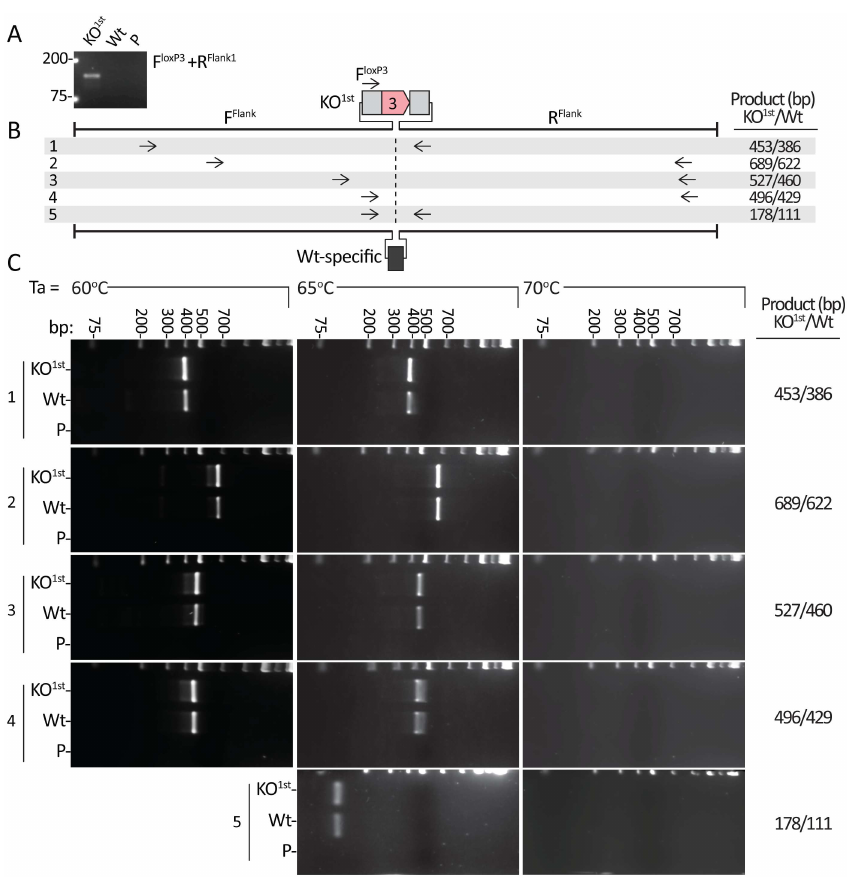
Fig 3. Targeting alternative flank positions or altering the PCR annealing temperature does not render templates containing the synthetic loxP3 region susceptible to amplification. A. PCR using the F loxP3 and R Flank1 primers correctly distinguished the genotypesof a KO 1st chimera (band at 136 bp) from a Wt mouse, using DNA isolated from brain tissue. B. Bindingsites and predicted PCR product sizes for five primer pairs that target Wt sequences flanking the synthetic loxP3 region in KO 1st templates and an eleven bp Wt-specific sequencein Wt templates. C. PCR was performed with the samples from A. and the primer pairs indicatedin B. with the annealing temperature (Ta) set to 60˚C, 65˚C or 70˚C. Products were separated on 2.5% agarose gels containing GelRed stain. DNA samples from the same KO 1st chimeric mouse and Wt mouse were used throughout this figure. Abbreviations: P = primers